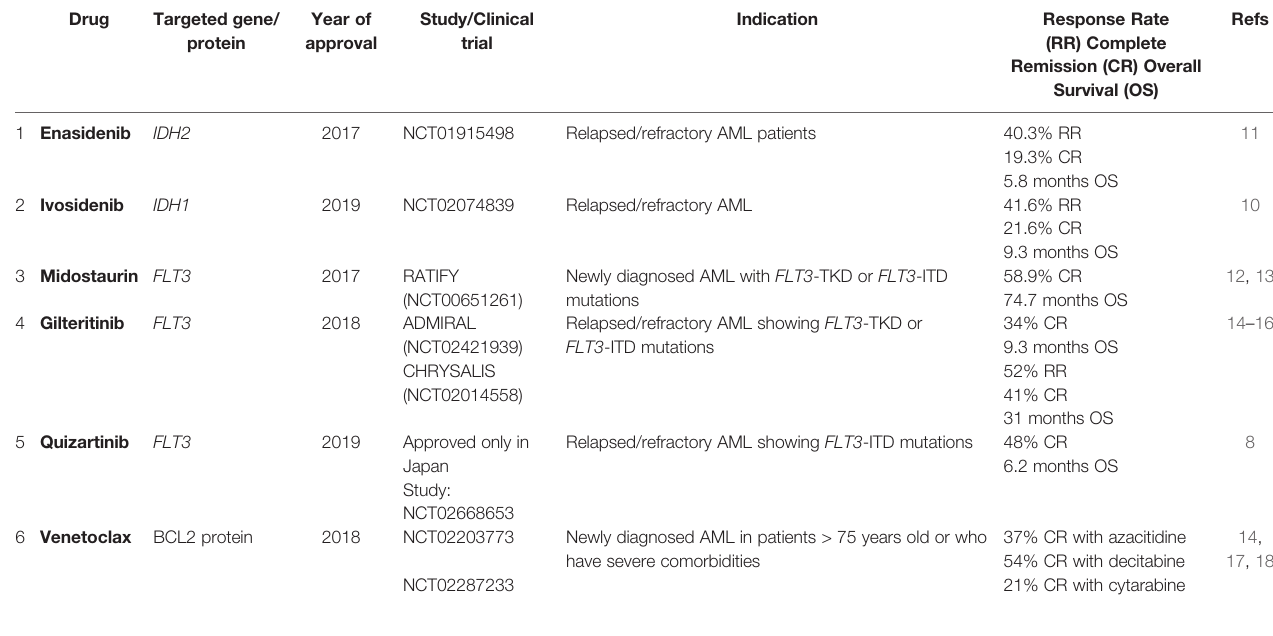
TABLE 1 | Summary of key FDA approved targeted therapy for acute myeloid leukemia treatment.